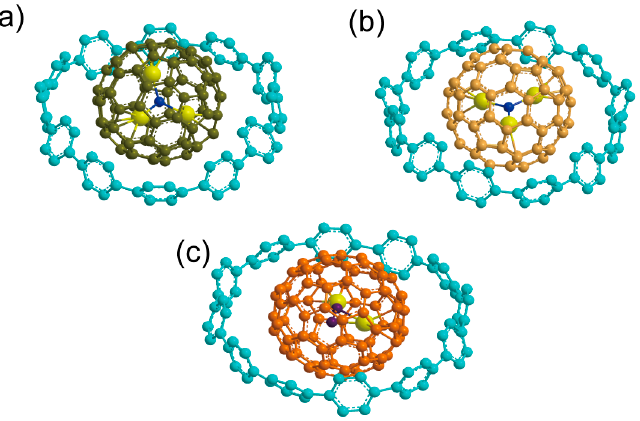
Figure 1. Optimized structures of ( a ) Sc 3 N@C 78 ⊂ [12]CPP, ( b ) Sc 3 N@C 80 ⊂ [12]CPP, and ( c ) Figure Sc 2 C 2 @C 82 ⊂ [12]CPP, respectively.